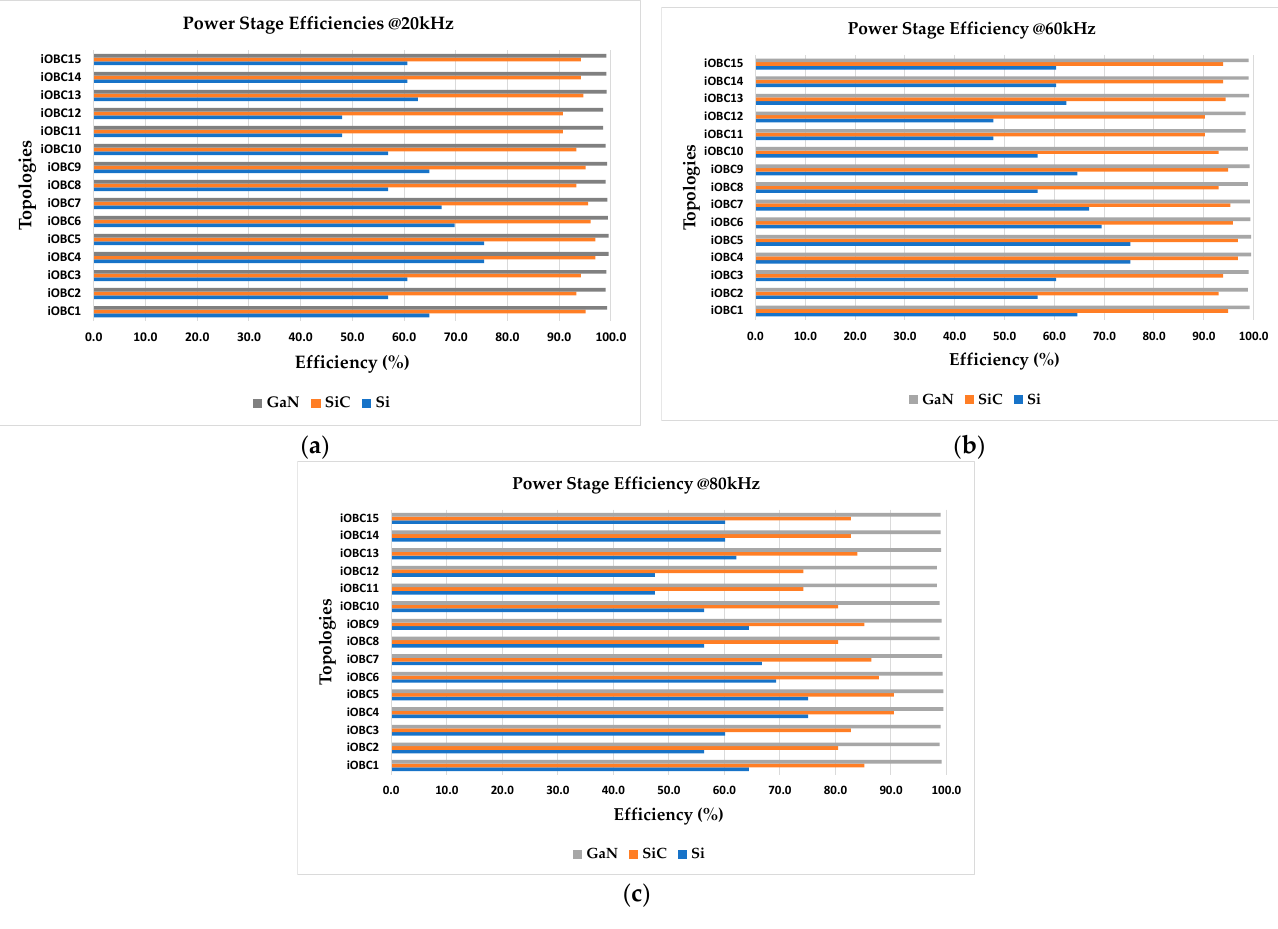
Figure 32. Estimated efficiencies for all considered iOBC power stages with different switching technologies. ( a ) 20 kHz, ( b ) 60 kHz, ( c ) 80 kHz.